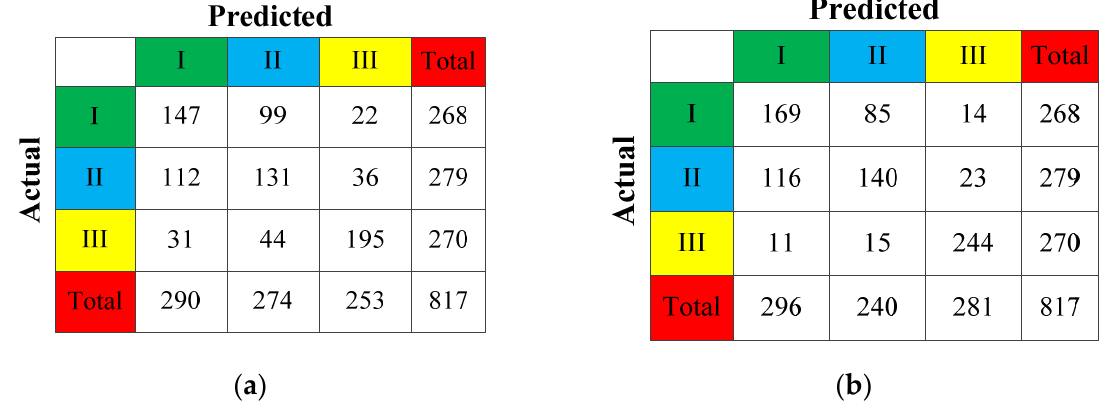
Figure 6. The confusion matrices with testing data.( a ) Scheme A confusion matrix with unreduced attributes. ( b ) Scheme B confusion matrix with reduced attributes.